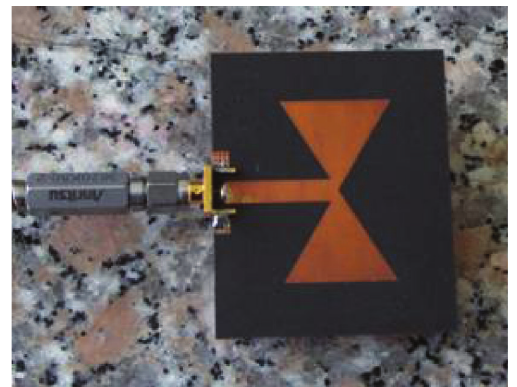
Figure 10: Antenna prototype for the channel model verification.